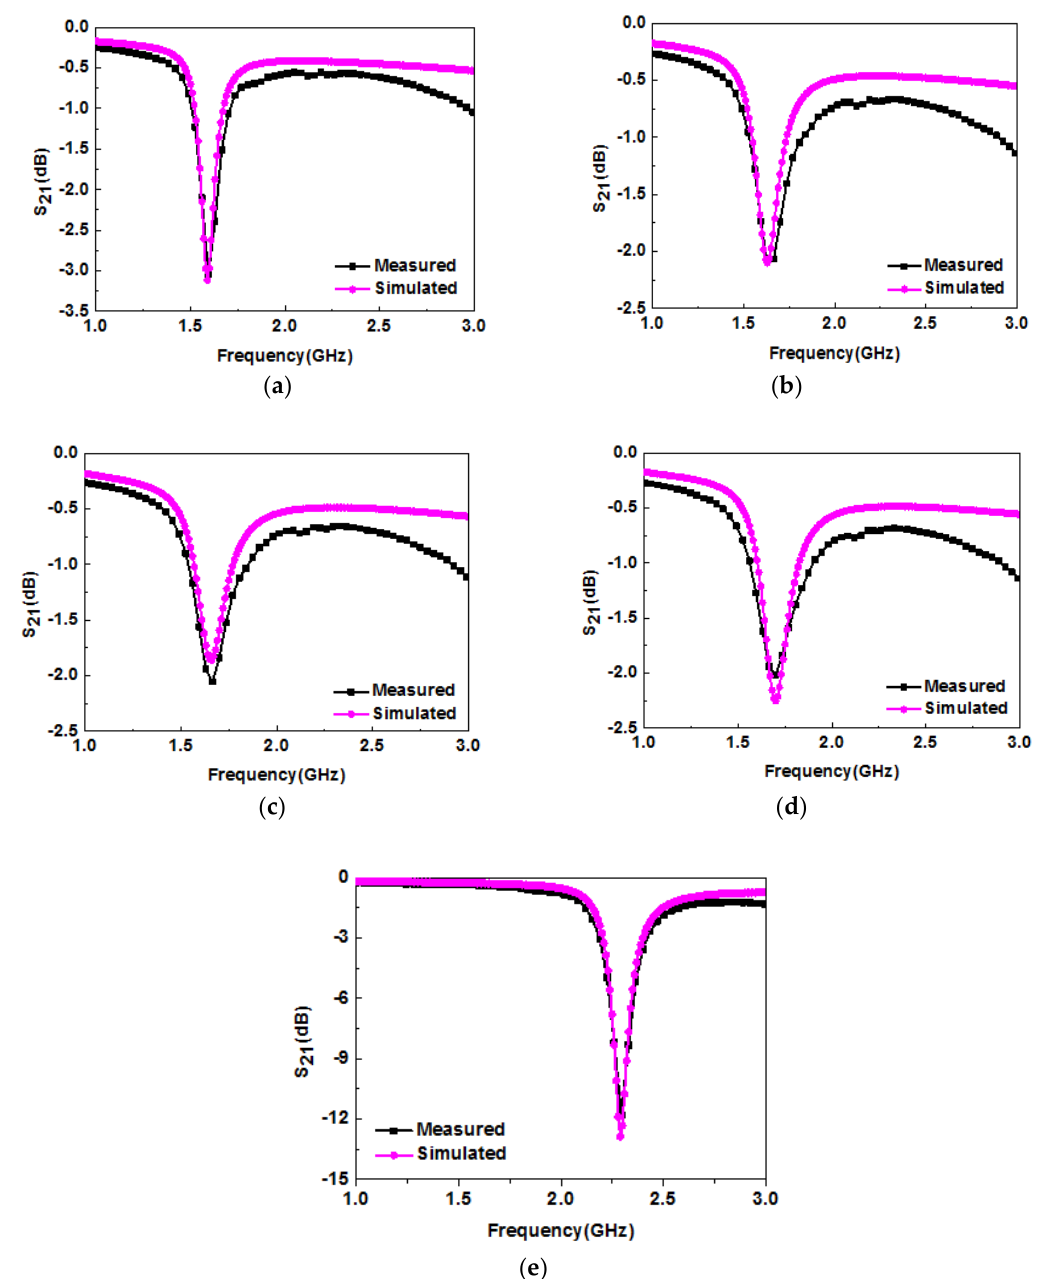
Figure 12. Simulated and measured resonance characteristics of ( a ) deionized water; ( b ) red wine; ( c ) milk; ( d ) yogurt; ( e ) peanut oil.